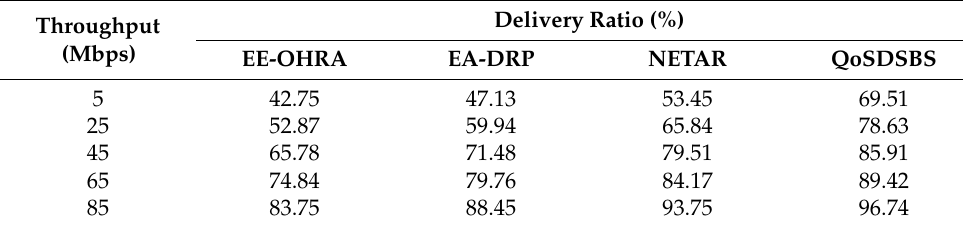
Figure 7. Throughput vs. delivery ratio. Table 4. Results of throughput vs. delivery ratio.